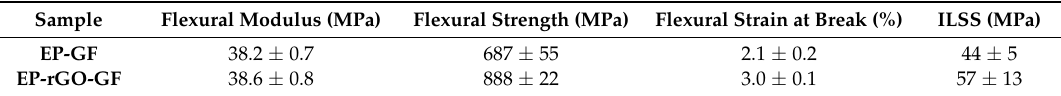
Table 5. Flexural properties and interlaminar shear strength (ILSS) values of the prepared composites.